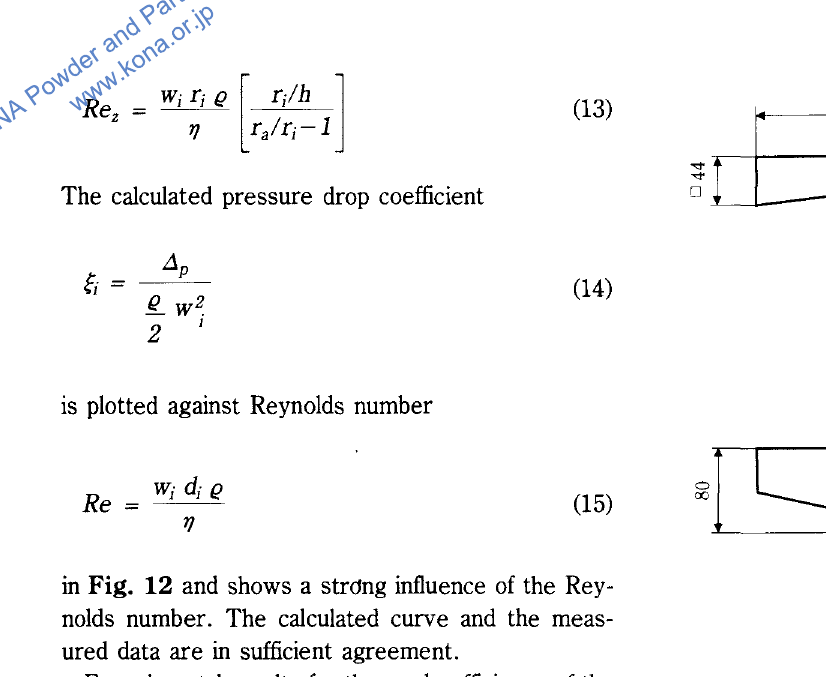
Fig. 12 Pressure drop coefficient dependent on Reynolds number between these particles leaves the balance area at z + dz. This calculation has to be repeated for all particle sizes and all cyclone heights. A particles